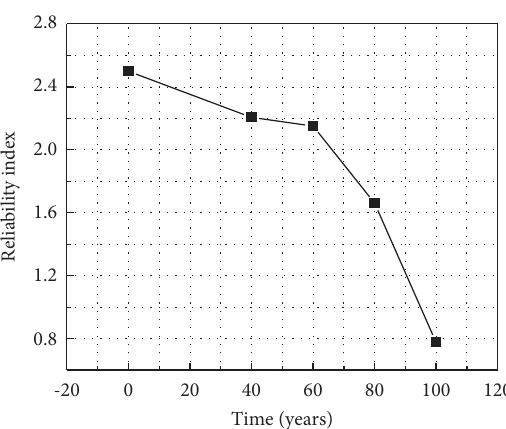
Figure 7: Trends in ship-crash time-dependent reliability indicators.